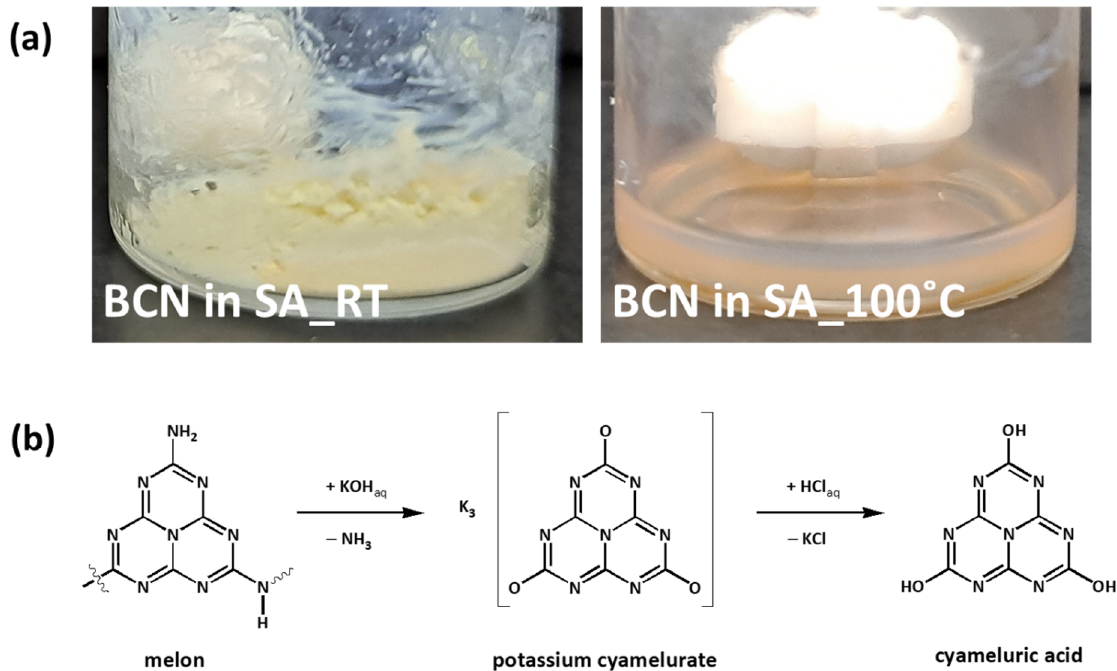
Figure 1. ( a ) Photo image of bulk g-CN (BCN) dissolved in high-concentrated sulfuric acid (SA) at room temperature (RT) and 100 °C, ( b ) schematic description of the synthesis of cyameluric acid from melon with KOH and HCl treatment [21].